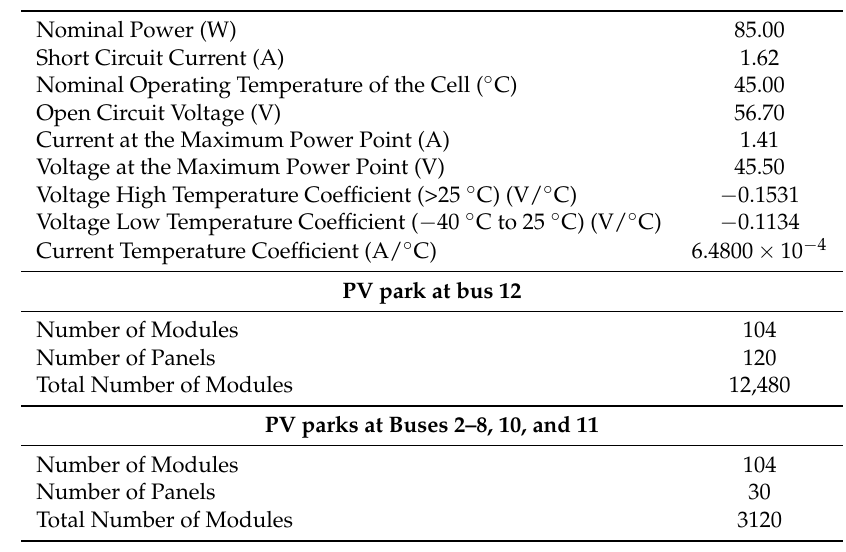
Table 4. PV characteristics.